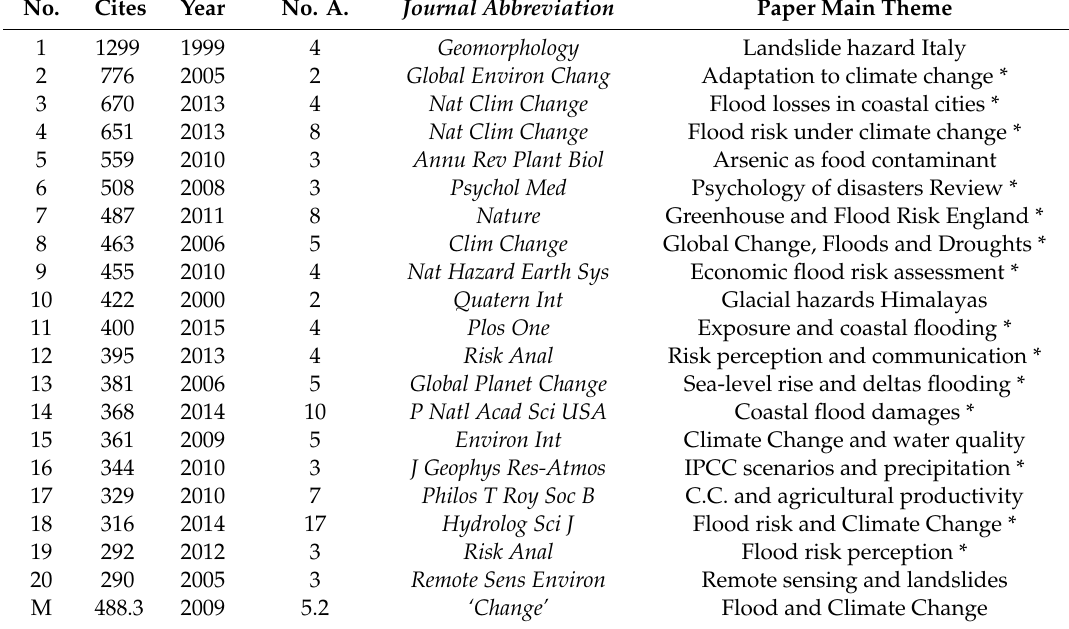
Table 3. List showing the 20 most cited FRAs records (research spotlights) in WoS databases, including: times cited, publication year, number of authors (No. A.), journal title abbreviations and the main theme of papers. *, directly related to FRA; and the mean values and modal words